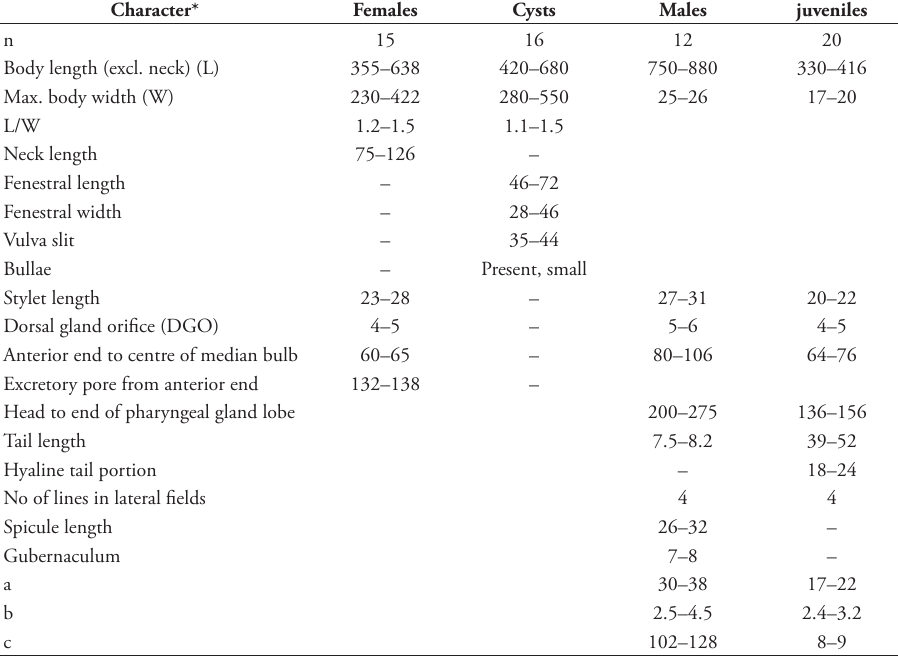
Table 1. Morphometrics of an Italian population of Heterodera fici isolated from roots and soil around roots; specimens mounted in water agar temporary slides (Measurements are in